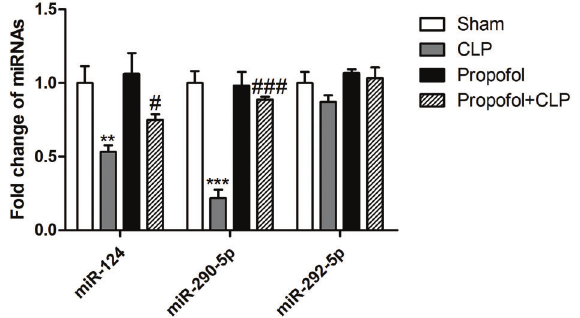
Figure4. Effects of propofol24hafter cecalligationandpuncture(CLP) on renal expression of miR-124, miR-290-5p, and miR-292-5p was measured by RT-qPCR in kidneys. Data are reported as means ± SD (n=12 per group). **P o 0.01, ***P o 0.001 compared with the sham group; # P o 0.05, ### P o 0.001 compared with the CLP group (ANOVA).